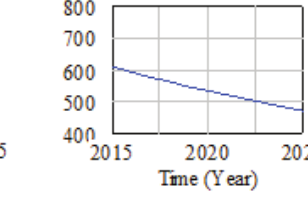
Fig. 17. Electricity loss.